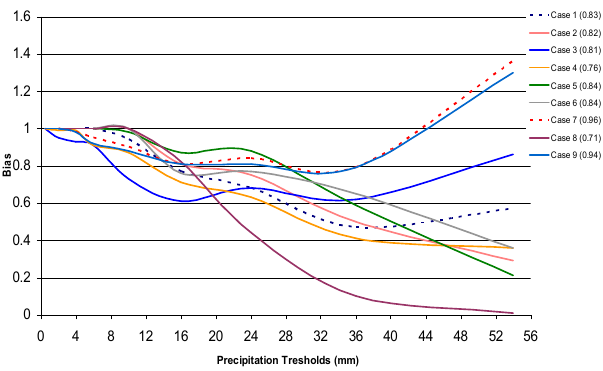
Fig. 13. Bias of the 24h accumulated precipitation for 86 stations and for nine scenarios of aerosol composition. The average bias for each scenario is specified in parenthesis after the legend labels. The number of available stations for each threshold is also denoted in parenthesis after the precipitation heights: 0.5 (86), 2 (86), 4 (86), 6 (86), 10 (84), 16 (81), 24 (57), 36 (34), 54